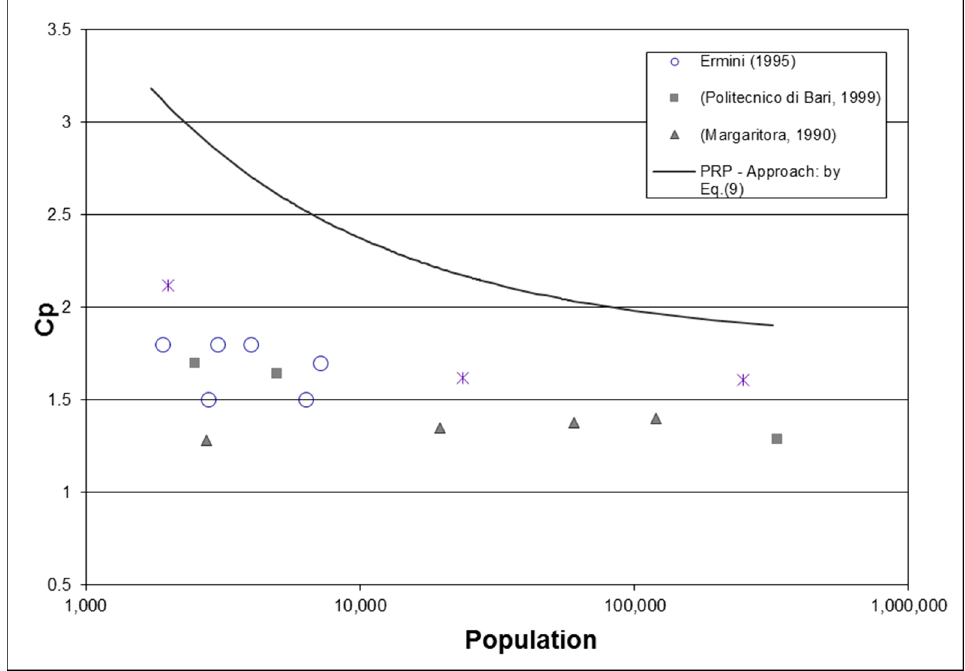
Figure 8. Theoretical relationship curve and measured data of others Italian studies using the logarithmic scale of population.